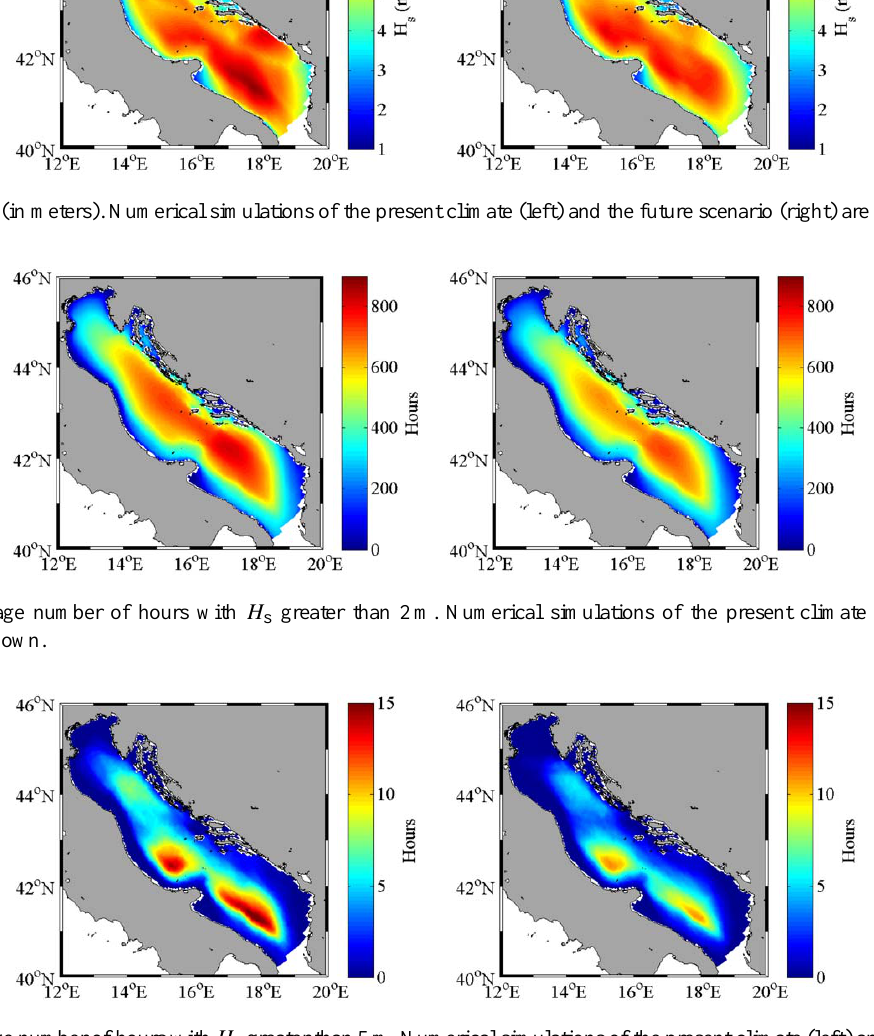
Fig. 11. Yearly average number of hours with H s greater than 5m. Numerical simulations of the present climate (left) and the future scenario (right) are